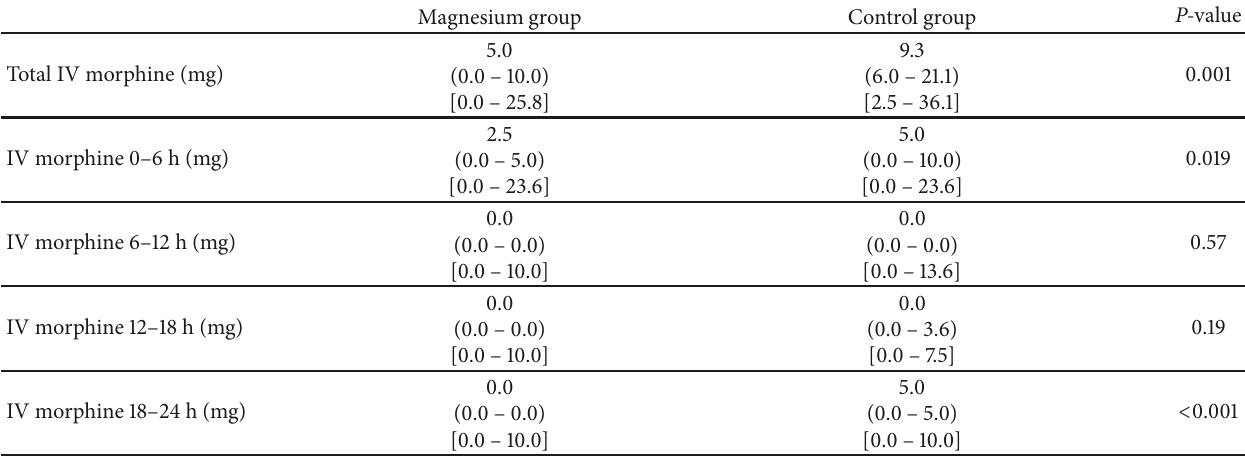
Table 3: Intravenous morphine requirement in first 24 hours following caesarean delivery ∗